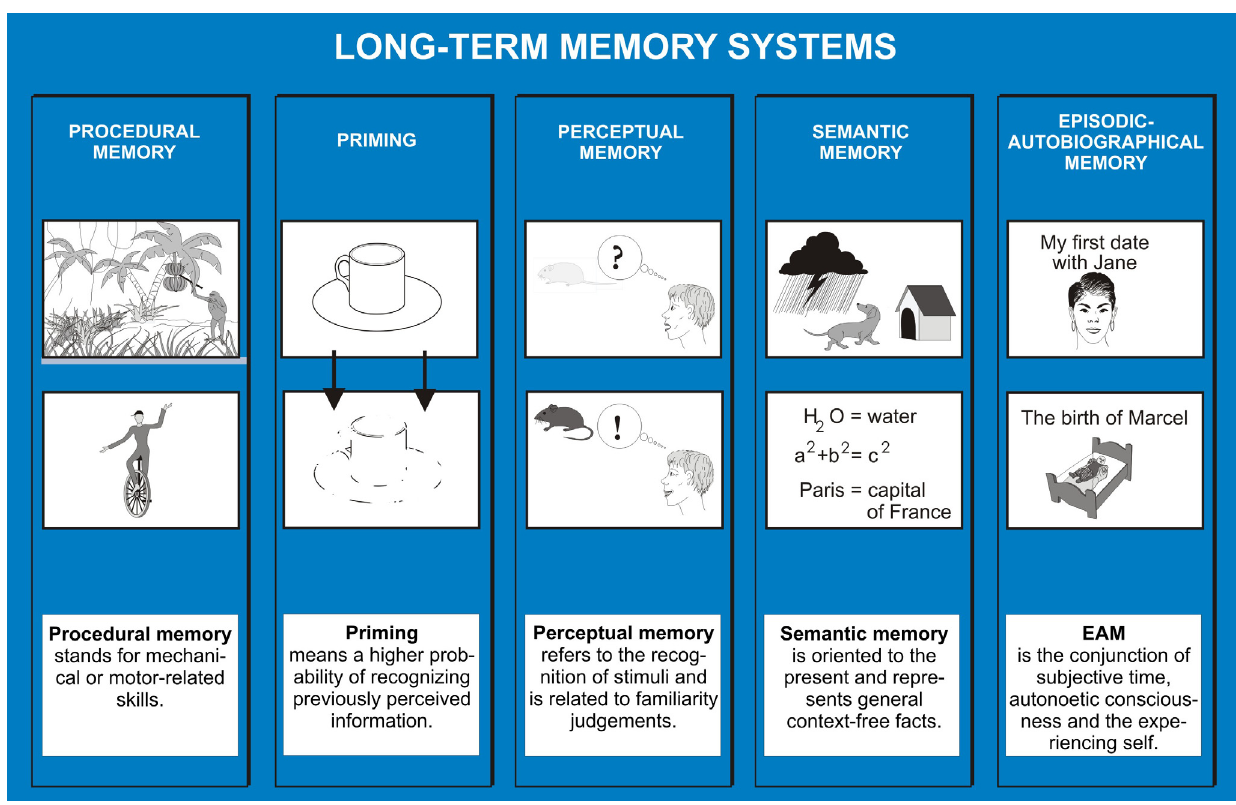
Figure 1. Sketch of the five long-term memory systems. Note that it is assumed that they develop both phylo- and ontogenetically from left to